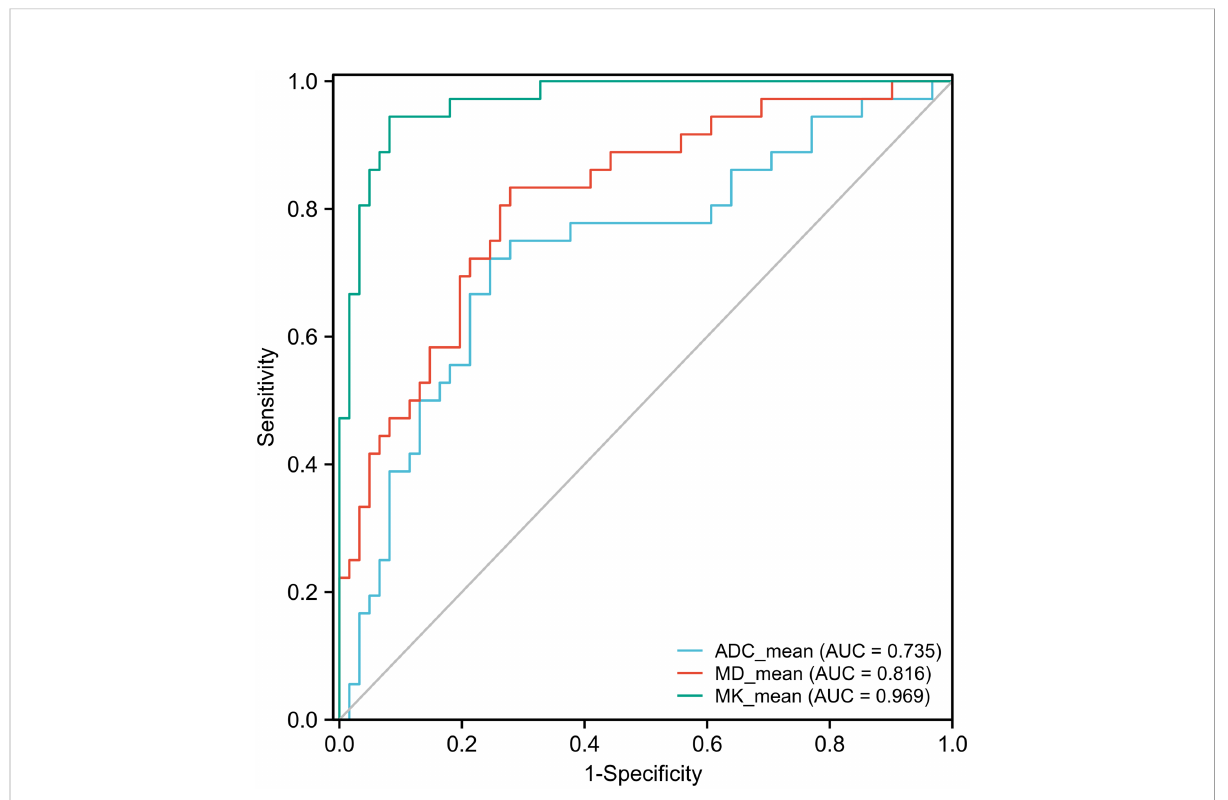
FIGURE 4 Receiver operating characteristic (ROC) curves of the ADC, MK, and MD for discriminating MVI. The area under the curve (AUC) values of the ADC, MD, and MK were 0.735 (95% CI: 0.635-0.819), 0.816 (95% CI: 0.725-0.888), and 0.969 (95% CI: 0.912-0.994), respectively. The AUCs of the ADC, MD, and MK were statistically signi fi cant from each other ( P